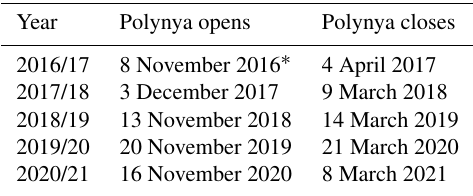
Table 1. Summer polynya opening and closing dates for each sum- mer 2016/17–2020/21 as determined by visual analysis of Sentinel- 1 SAR imagery. We determine the polynya to be open for summer when the majority of the open polynya is not exhibiting ice pro- duction and closed when the majority of the polynya is exhibiting ice production. ∗ In 2016/17 a lack of imagery in early November means it is difficult to determine when the polynya opened, but it is open by 8